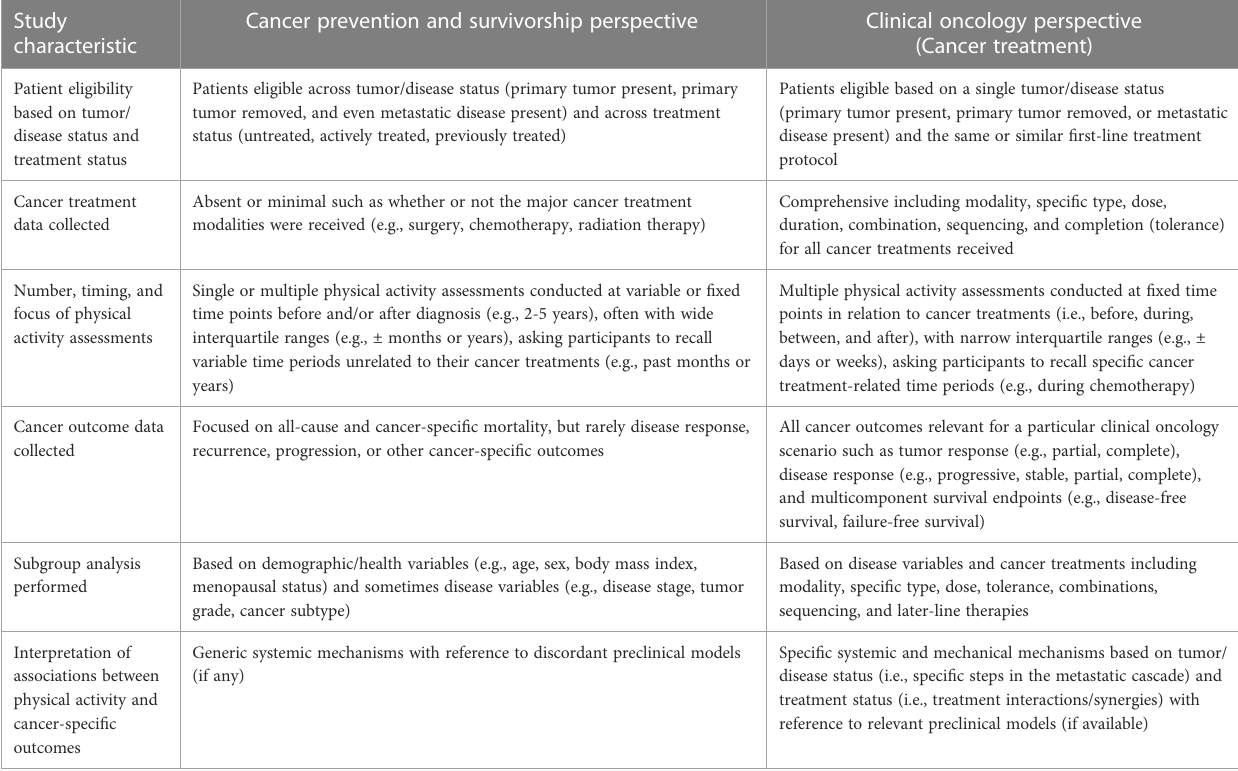
TABLE 3 Comparison of observational studies of physical activity and cancer outcomes conducted from a cancer prevention/survivorship versus clinical oncology perspective. Study